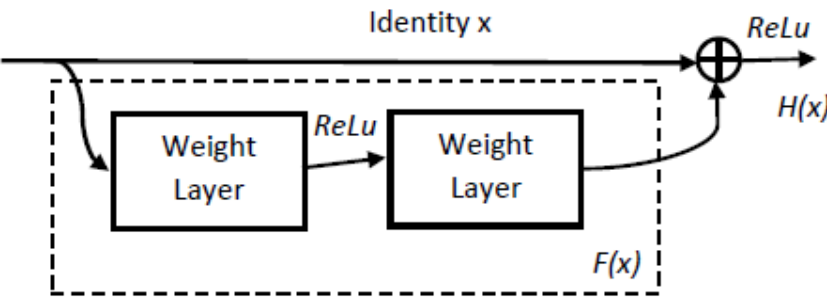
Figure 5. A generalized illustration of the modifications present in a deep residual network building block using identity